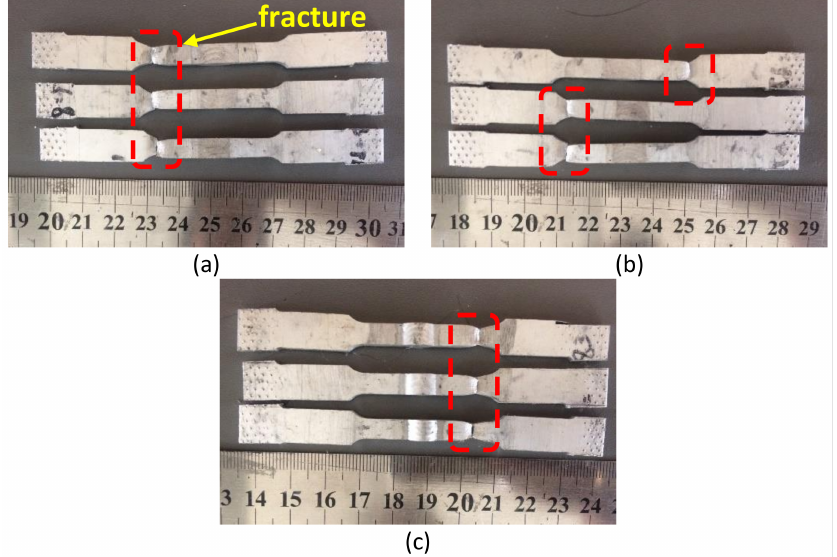
Figure 8. Fracture location of specimens at ( a ) R4-8 mm·s − 1 , ( b ) R5-12 mm·s − 1 and ( c ) R6-16 mm·s − 1